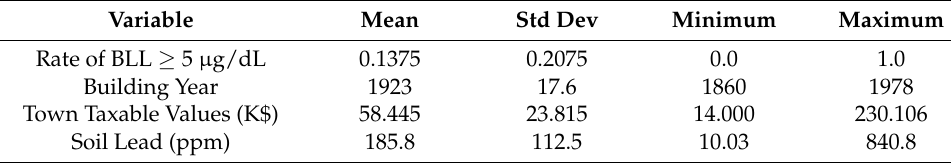
Table 1. Descriptive statistics of variables used in this study (n =